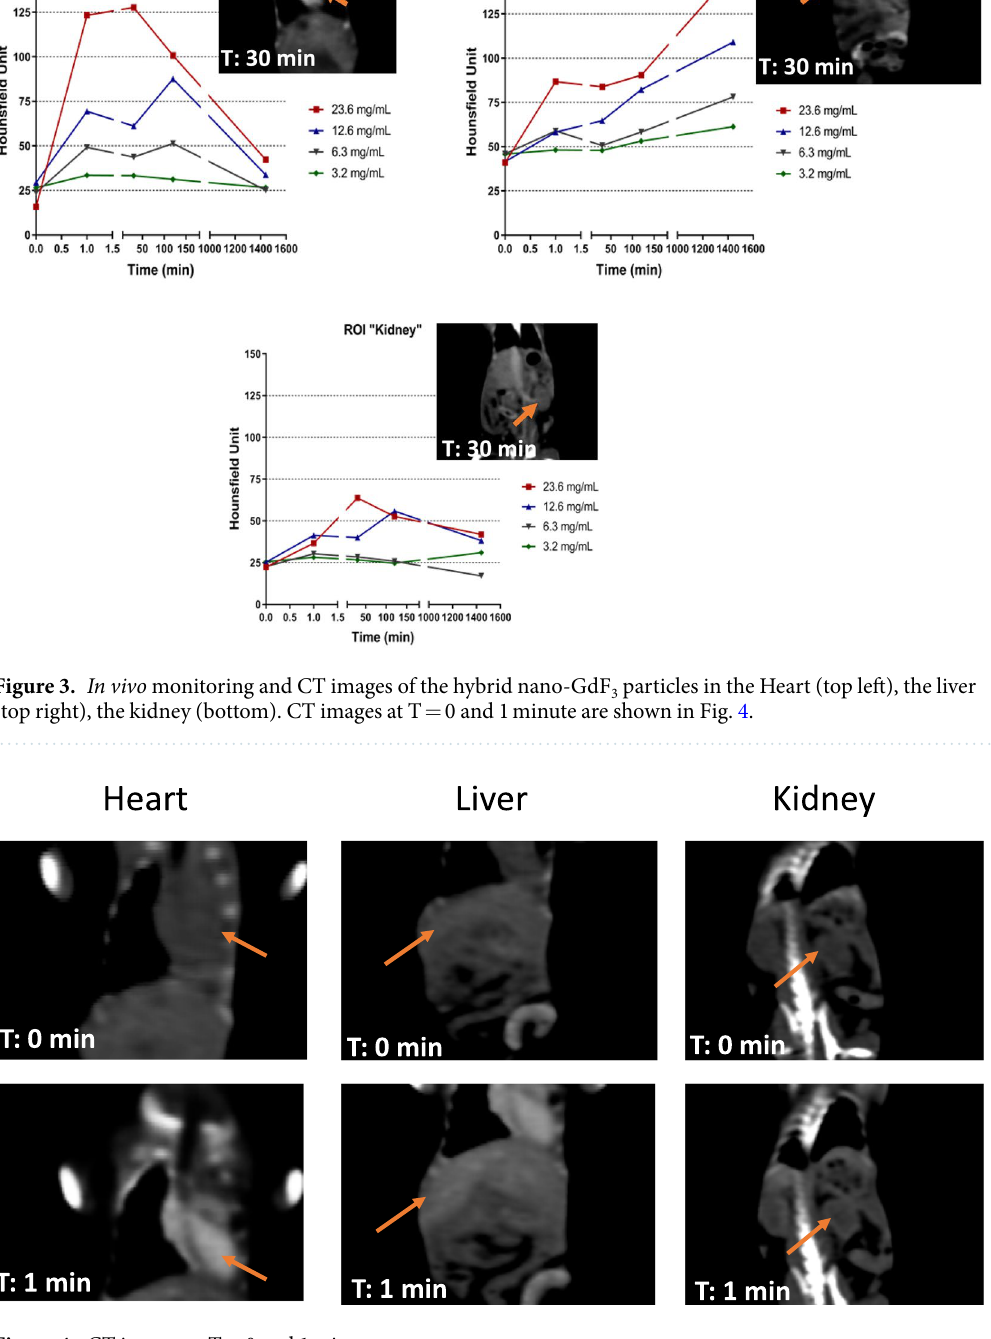
Figure 4. CT images at T = 0 and 1